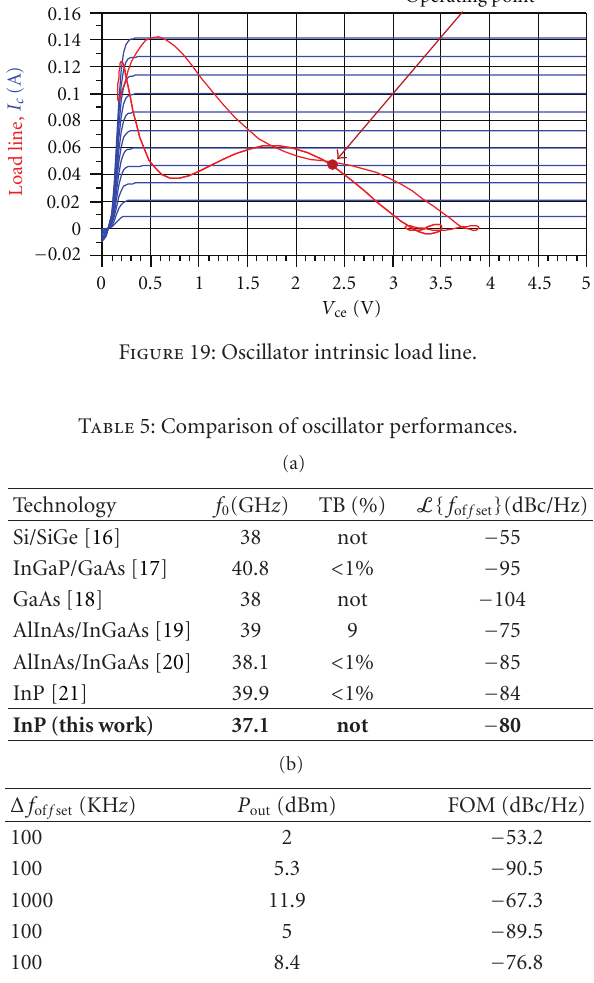
Figure 17: Magnitude and phase of open loop gain.